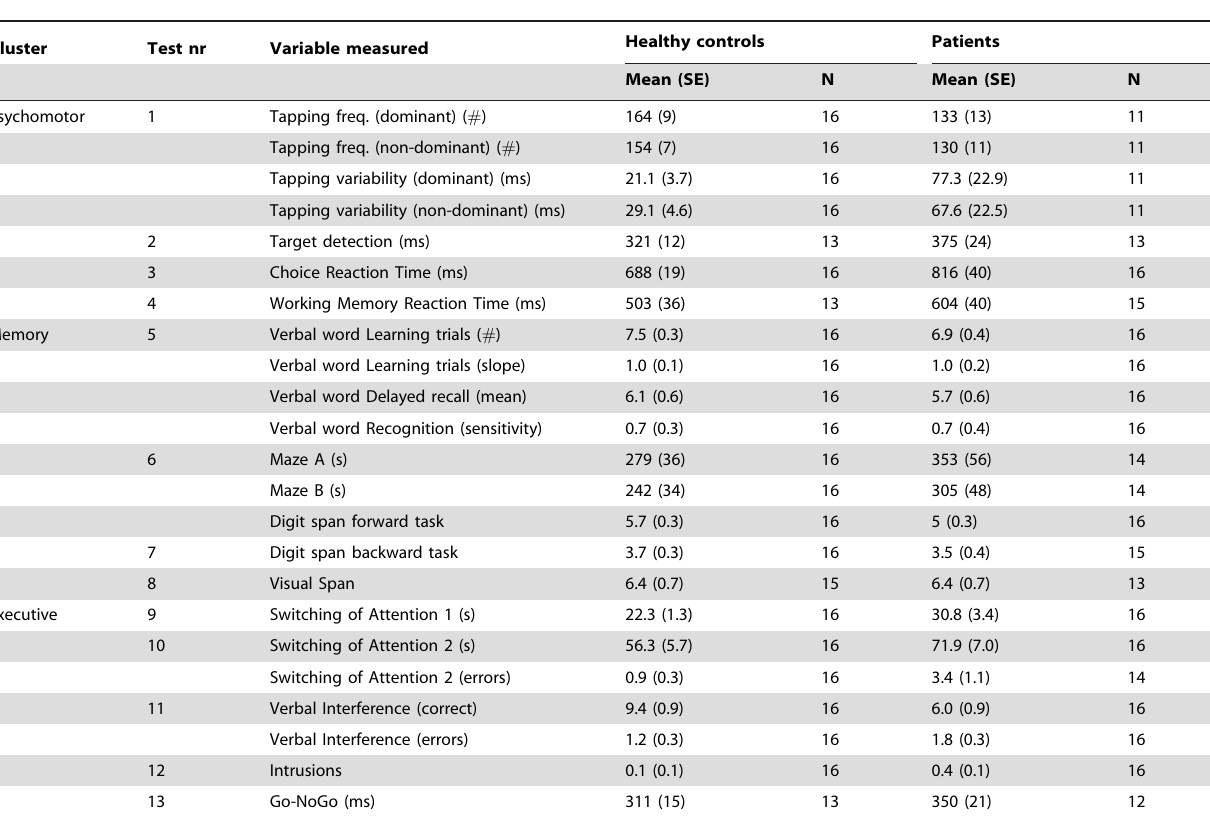
Table 2. Raw scores of the participants of all the